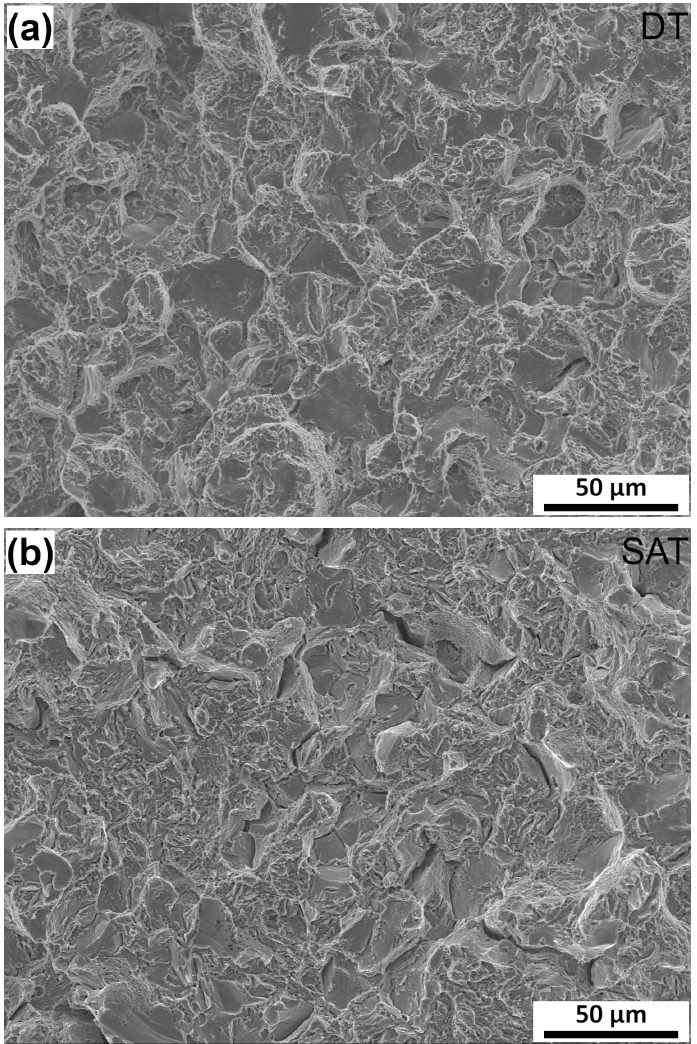
Figure 3. Fracture surfaces of impact toughness samples: ( a ) DT sample and ( b ) SAT sample observed by SEM in a secondary electron mode.